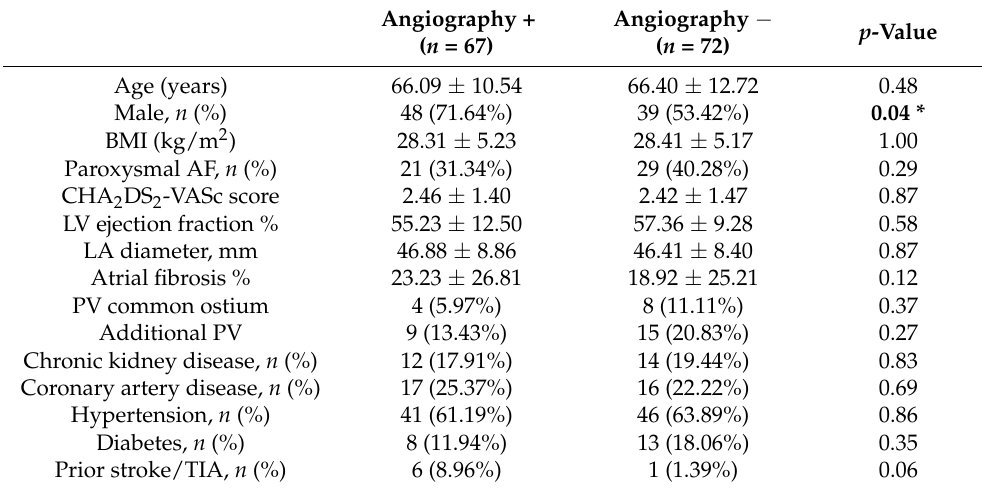
Table 1. Baseline Clinical Characteristics ( n = 139).